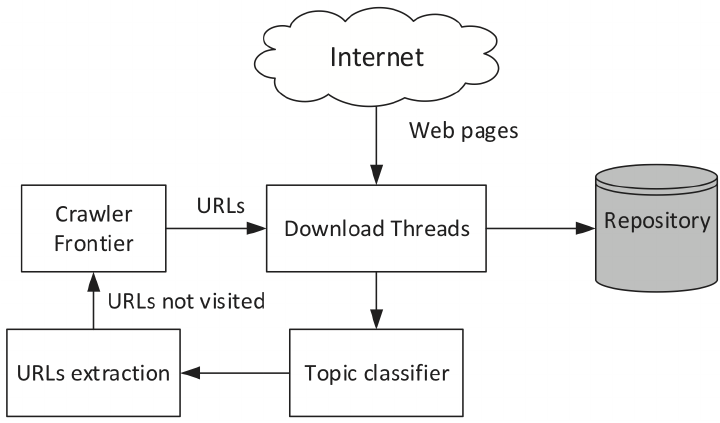
Figure 1. General focused web crawler